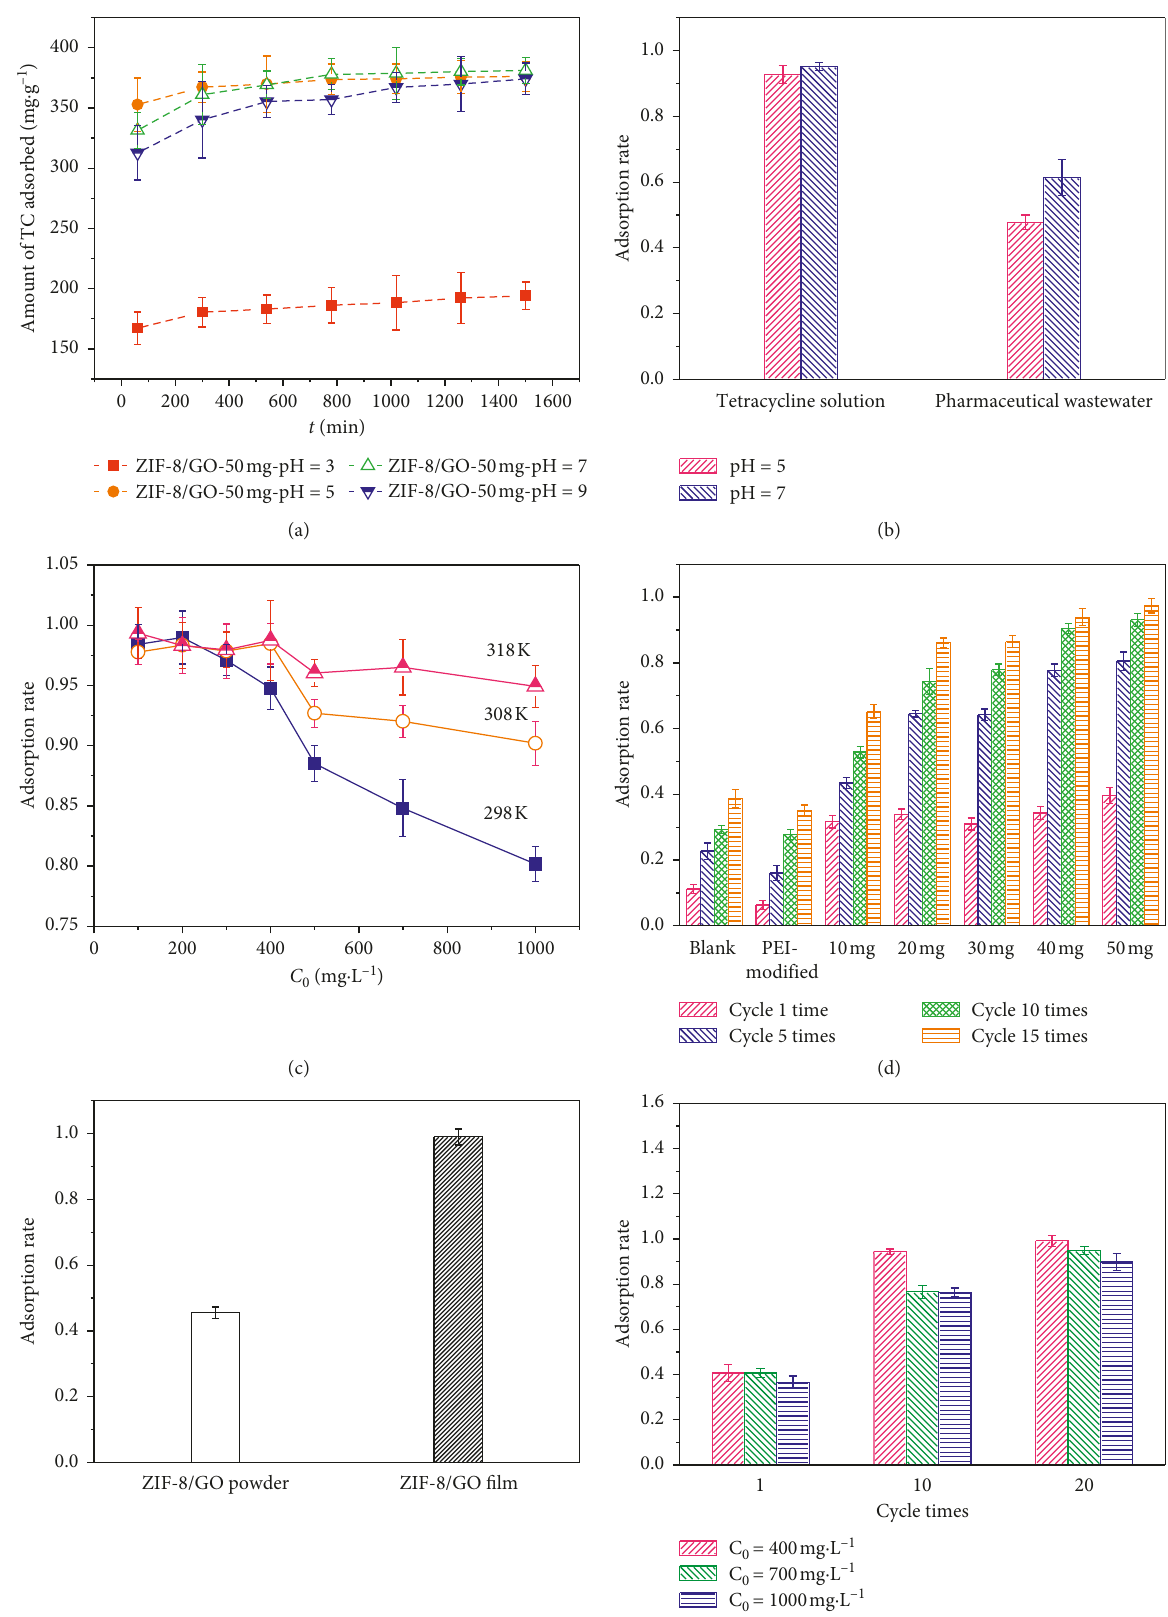
Figure 8: (a) Adsorption capacity of ZIF-8/GO powder in TC aqueous solution. (b) Adsorption rate of ZIF-8/GO powder in TC aqueous solution. (c) Adsorption rate of TC in aqueous solution by ZIF-8/GO powder at different temperatures. (d) Adsorption rate of TC on the composite film. (e) Adsorption rate of TC by different materials. (f) Adsorption rate of TC in aqueous solution by the composite film with different